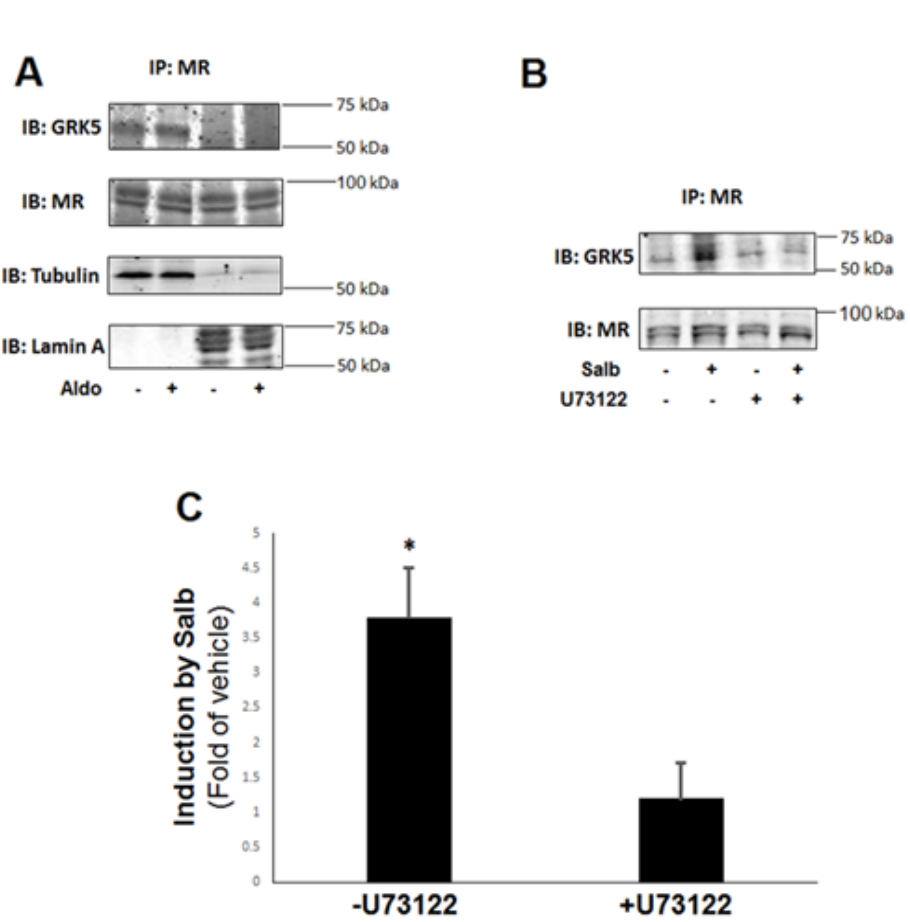
Figure 6. β 2 AR induces GRK5 translocation to the cytoplasm for subsequent MR phosphorylation. ( A ) H9c2 cardiomyocytes were untreated or treated with 100 nM Aldo for 30 min. Subsequently, whole cell protein lysates were prepared and subjected to subcellular fractionation. Cytosolic and nuclear extracts fractions were separately immunoprecipitated (IP) with an anti-MR antibody, and the IPs were then immunoblotted (IB) for GRK5. Representative blots from six independent experiments are shown, including blots for MR to confirm equal amounts immunoprecipitated and for tubulin (cytosolic marker) and lamin A (nuclear marker) to confirm the identity of the lysate fraction (cytoplasm or nucleus, respectively). No GRK5 immunoreactivity could be detected in the MR IPs derived from the nuclear lysates. ( B , C ) H9c2 cardiomyocytes were treated with 10 µM salbutamol (Salb) for 30 min in the presence or absence of 10 µM U73122, and then, whole cell lysates were prepared to IP the MR, followed by IB for GRK5. Representative blots are shown in ( B ), including blots for MR to confirm equal amounts immunoprecipitated, and the relative densitometric quantitation of six independent experiments done in duplicate is shown in ( C ). * p < 0.05; n = 6.